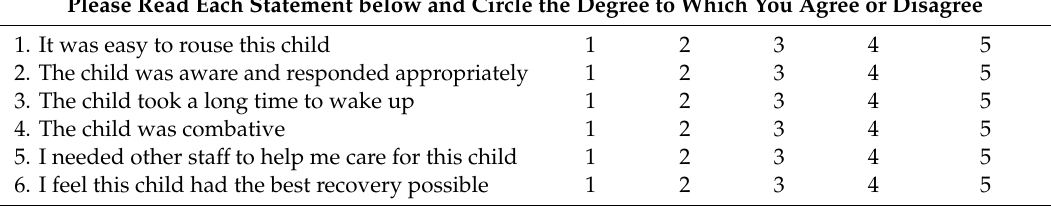
Table 1. Halifax post-myringotomy anesthesia recovery questionnaire. Completed by nurses providing post-operative care to patients having bilateral myringotomy with tympanostomy tube